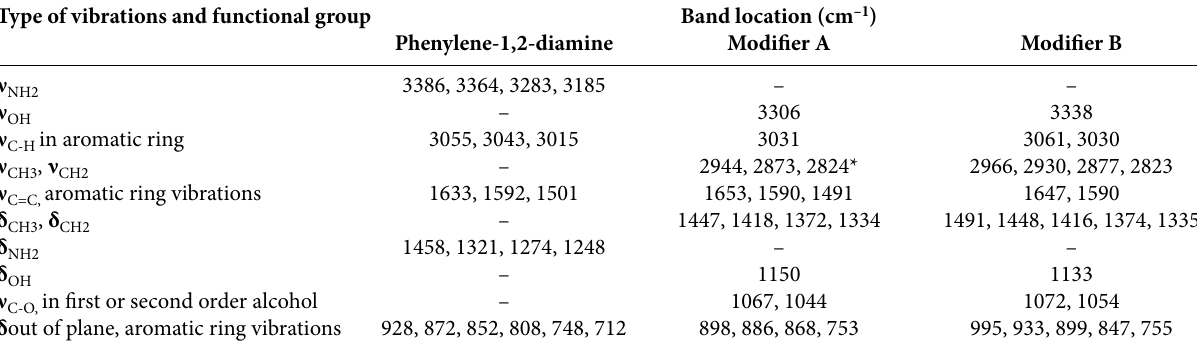
Table 2. Absorption Bands in IR Spectra of Phenylene-1,2-diamine and obtained Modifiers Type of vibrations and functional group